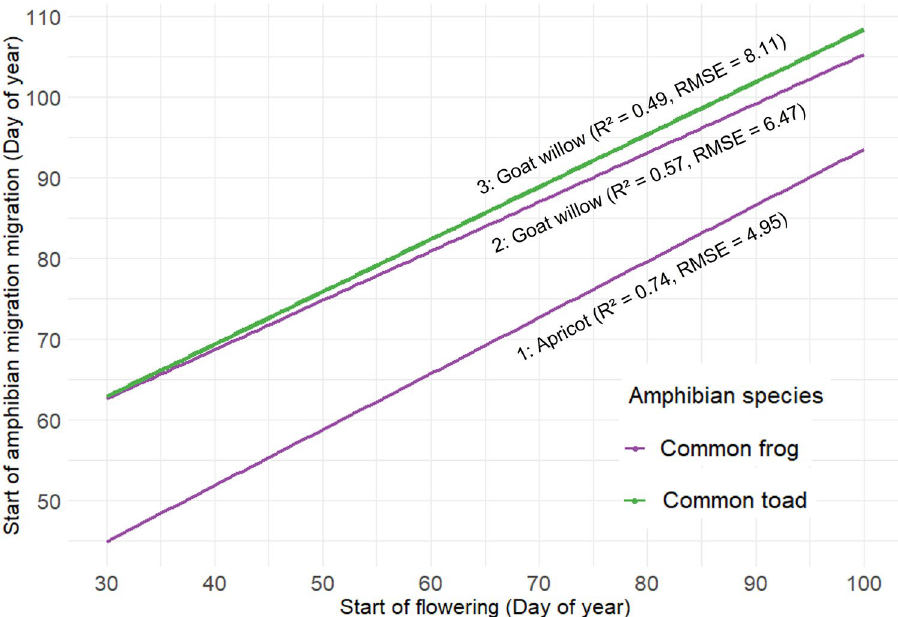
Figure 4. Regression models to predict migration of common frog (model 1 and 2) and common toad (model 3) with flowering of plants labelled. More specific predictions for moderate and cold regions can be derived from models in Supplementary Table